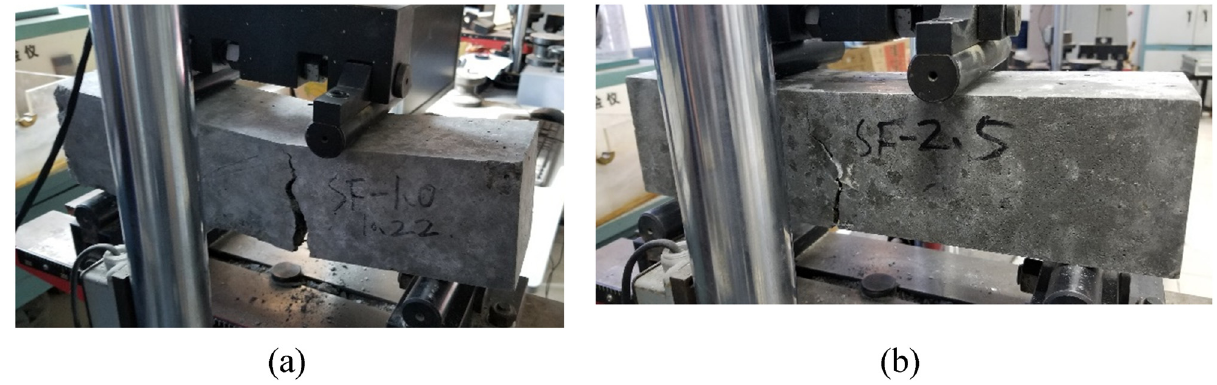
Figure 19: Flexural failure of test blocks with di ff erent fi ber contents: ( a ) 1.00% fi ber - reinforced specimen and ( b ) 2.50% fi ber - reinforced